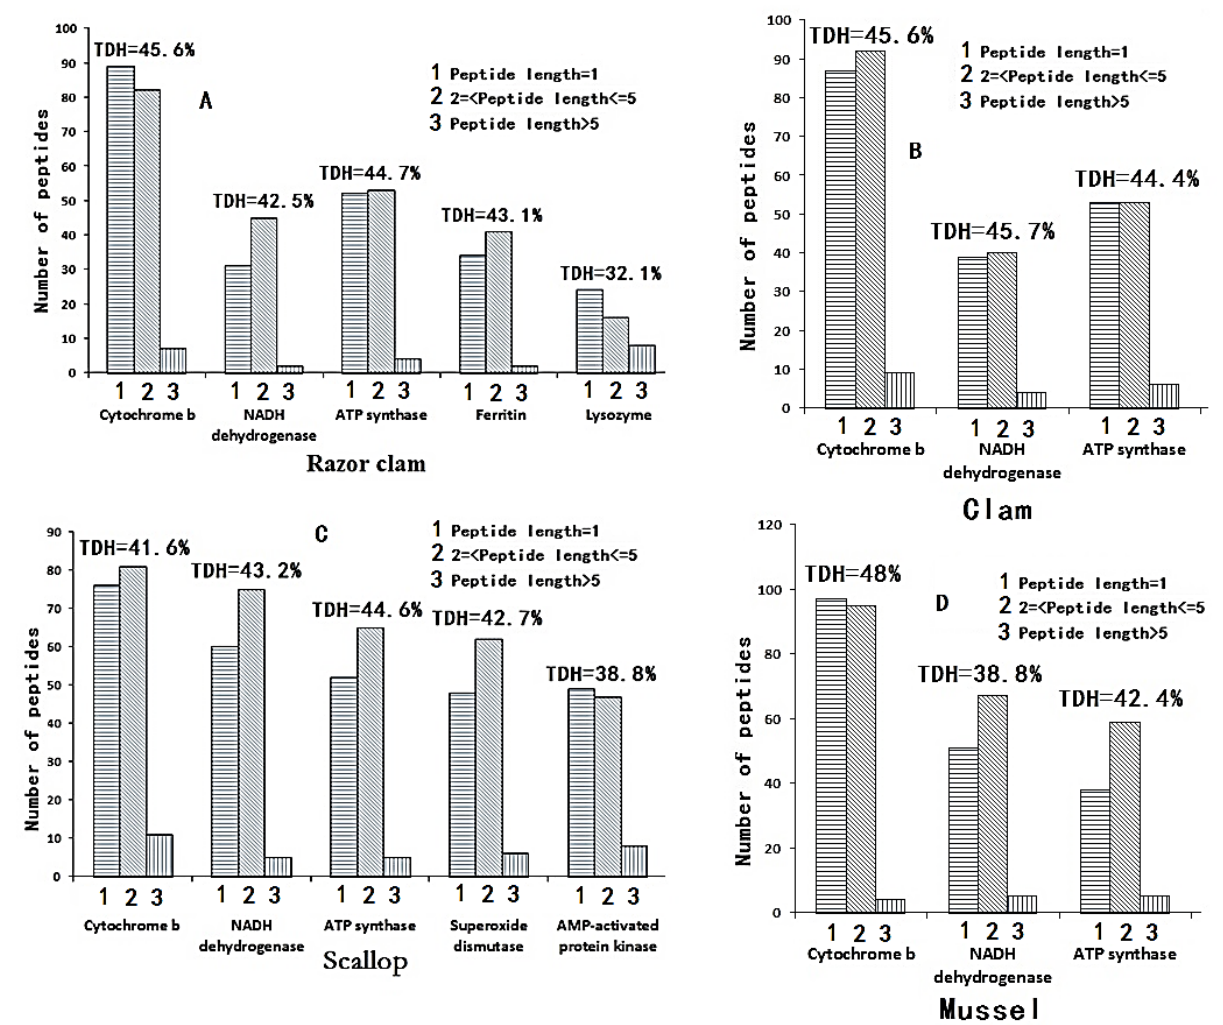
Figure 1. In silico hydrolysis of marine shellfish proteins. Sixteen proteins from four species of marine shellfish (razor clams ( A ), clams ( B ), scallops ( C ), and mussels ( D )) were selected, their amino acids sequences were retrieved from the NCBI database (https://www.ncbi.nlm.nih.gov/protein/, accessed on 5 March 2022), and their in silico hydrolysis by gastrointestinal enzymes (pepsin, trypsin, and chymotrypsin) (no order) was performed using the BIOPEP-UWM database (https://biochemia.uwm.edu.pl/biopep - uwm, accessed on 20 March 2022).